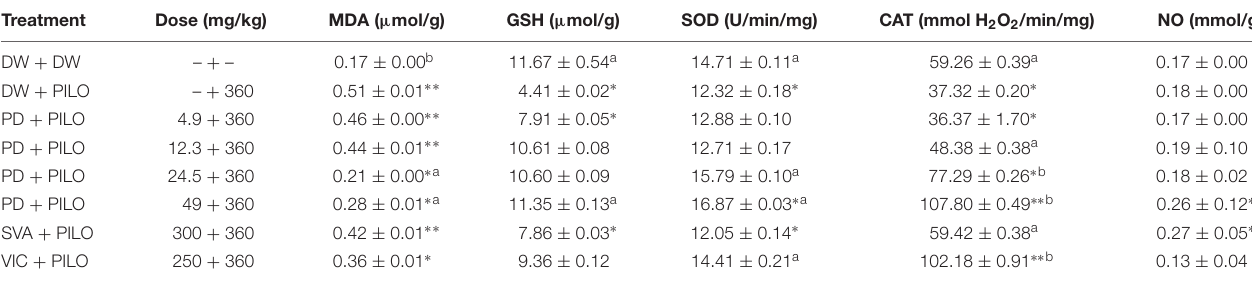
FIGURE 4 | Effects of P. daemia on total proteins level and AchE activity. (A) Effects of P. daemia on total proteins level in hippocampi of pilocarpine-injected mice. (B) Effect of P. daemia on AchE level in hippocampi of the same animals. Data are mean ± SEM, N = 7 per group. Newman Keul’s multiple comparisons post hoc test, with Mann–Whitney U test correction : (i) vs. control animals (DW + DW group) receiving only distilled water: ∗ p < 0.05, ∗∗ p < 0.01, ∗∗∗ p < 0.001; (ii) vs. disease control animals (DW + PILO group) receiving distilled water and pilocarpine: a p < 0.05, b p < 0.01. DW, distilled water; PD, Pergularia daemia ; PILO, pilocarpine; VIC, vitamin C; SVA, sodium valproate. TABLE 1 | Effects of P. daemia on antioxidant enzymes and oxidative stress markers in hippocampi of pilocarpine-injected mice.